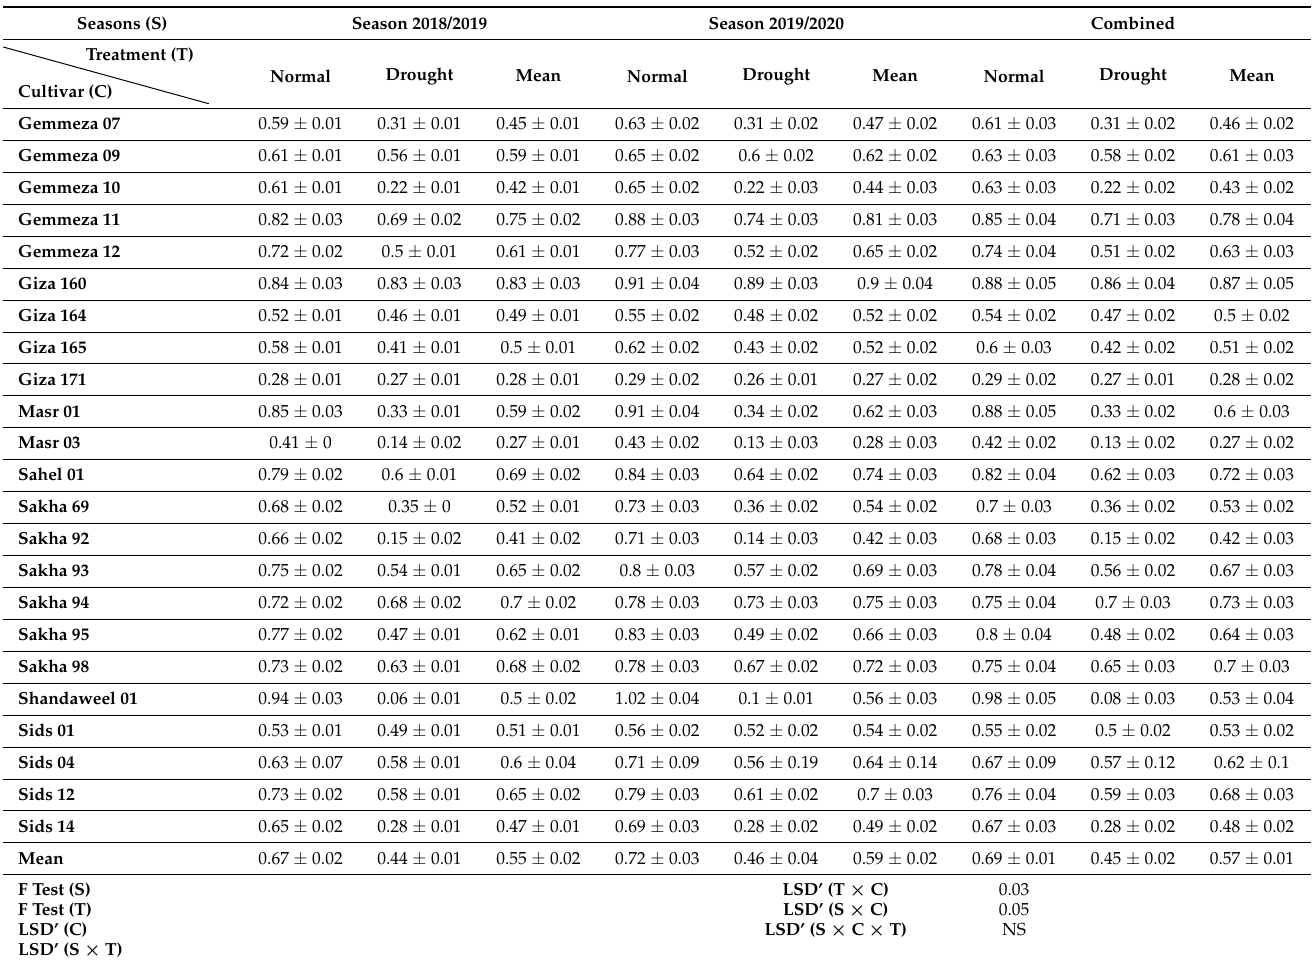
Table 5. Effect of drought stress on grain yield kg/m 2 (means ± SD) of some Egyptian